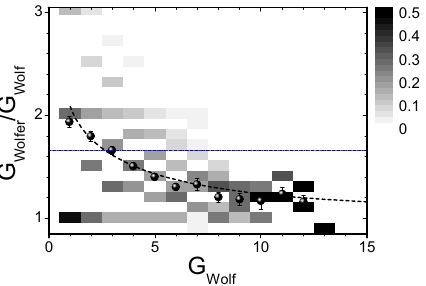
Fig. 3 Correction c -factor of Wolf to Wolfer. The grey scale represents the probability density function (PDF) of the ratio of the number of groups reported by Wolfer for days, when Wolf reported a given number of groups. The big dots with error bars depict the mean values. The dashed line is a functional exponential fit. The horizontal dot-dashed line represents the constant correction k -factor 1.667 (Clette et al. 2014). Modified after (Usoskin et al.